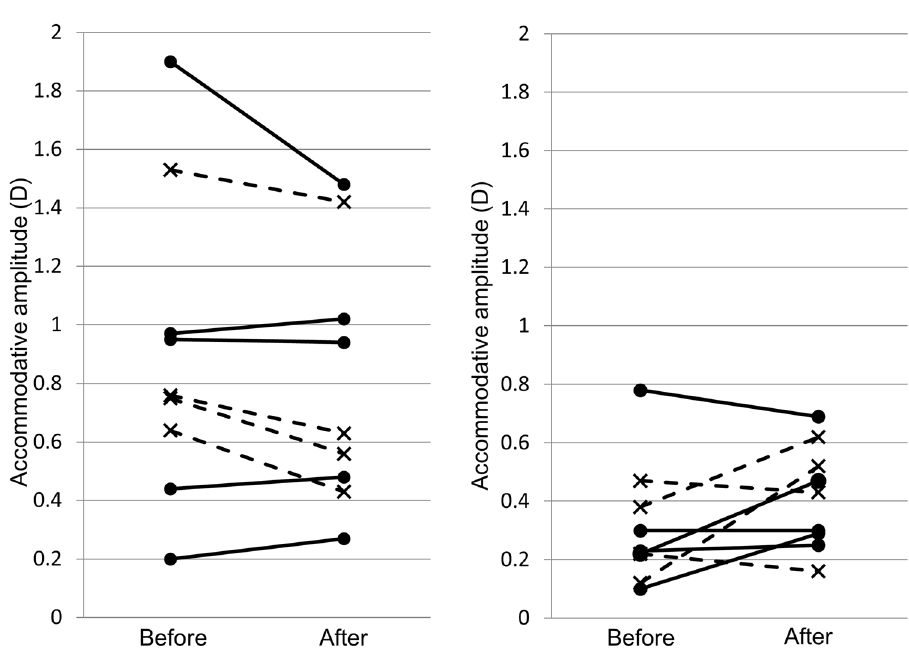
Figure 2. Accommodative amplitude before and after treatment in respective subjects. (Left) Subjects in their fifth decade of life; (right) subjects in their sixth decade of life. The solid lines and circles represent the treatment group; the dashed lines and crosses represent the control